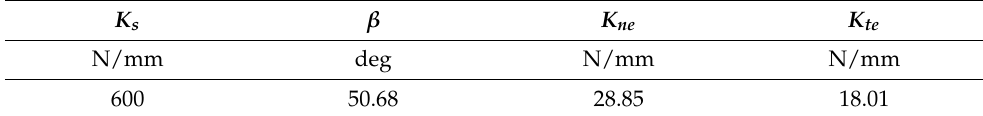
Table 3. The optimum set of specific cutting force coefficients by EO.